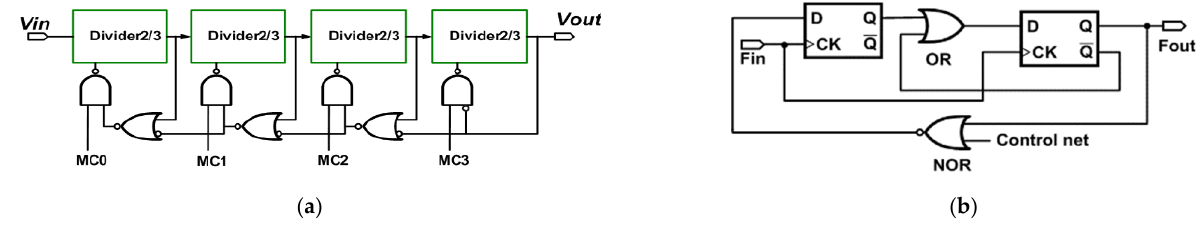
Figure 7. The proposed ( a ) Multiple modulus divider circuit; and ( b ) the 2/3 divider circuit.